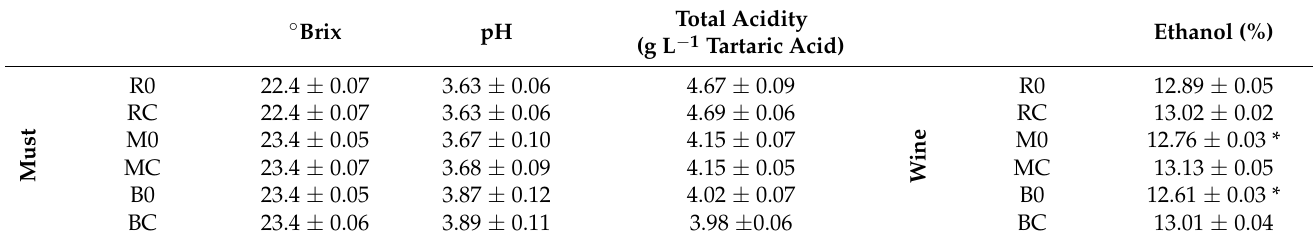
Table 1. Main parameters of the starting must and final wines ( n = 3).